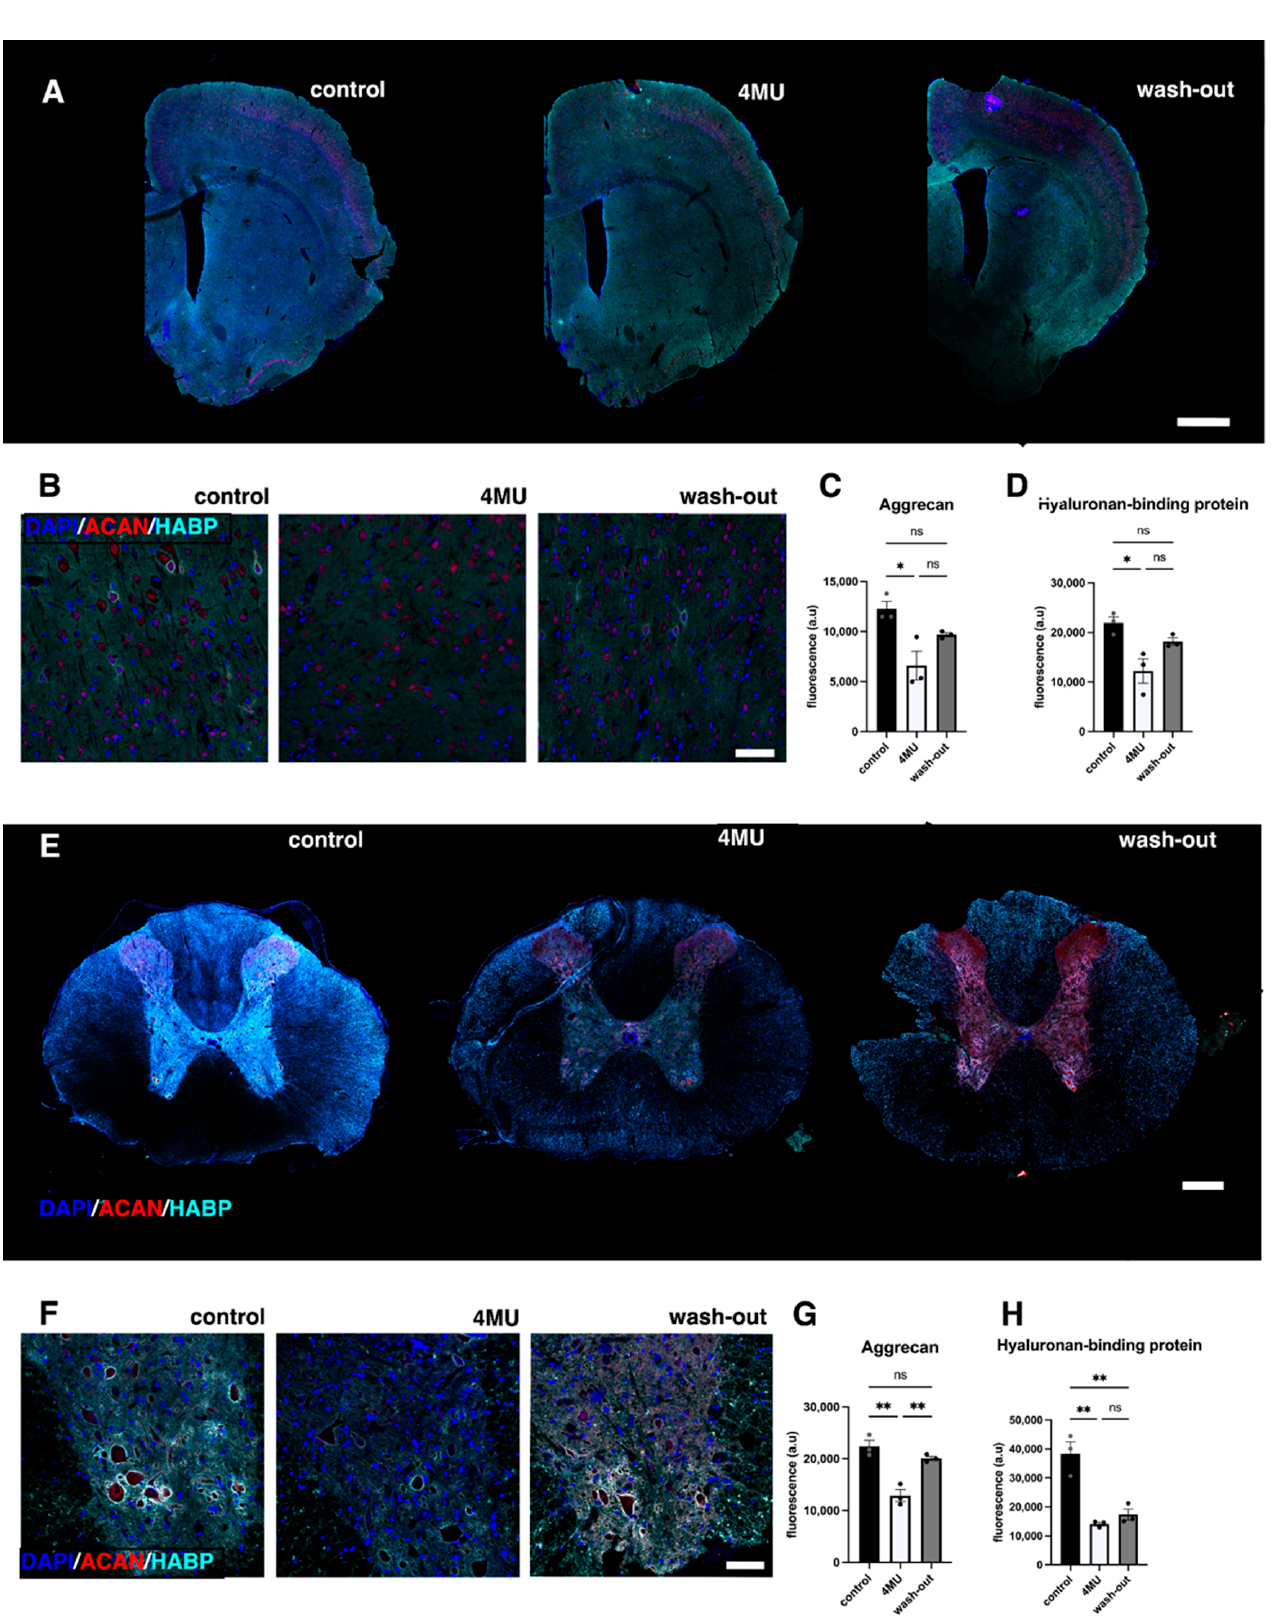
Figure 1. 4MU administered at a dose of 1.2 g/kg/day downregulates HA as well as PNNs in brain and spinal cord after 10 weeks of administration. ( A ) Representative confocal images showing HA- and ACAN-positive areas in brain sections in placebo-fed animals, 4MU-treated animals and animals after 9 weeks of wash-out period. Scale bar: 1000 µm. ( B ) Representative confocal images showing detail of the brain cortex. In 4MU-treated animals, HA and ACAN positivity is reduced compared to untreated controls and partially returns after the 9 week wash-out period. Scale bar: 50 µm. ( C , D ) Quantification of ACAN (red) and HABP signal in the brain cortex. The values are the means ± SEM for n = 3 in each group. ( E ) Representative confocal images showing HA (turquoise)-, ACAN (red)- and DAPI (blue)- positive areas in spinal cord sections in placebo-fed animals, 4MU-treated animals and animals after 9